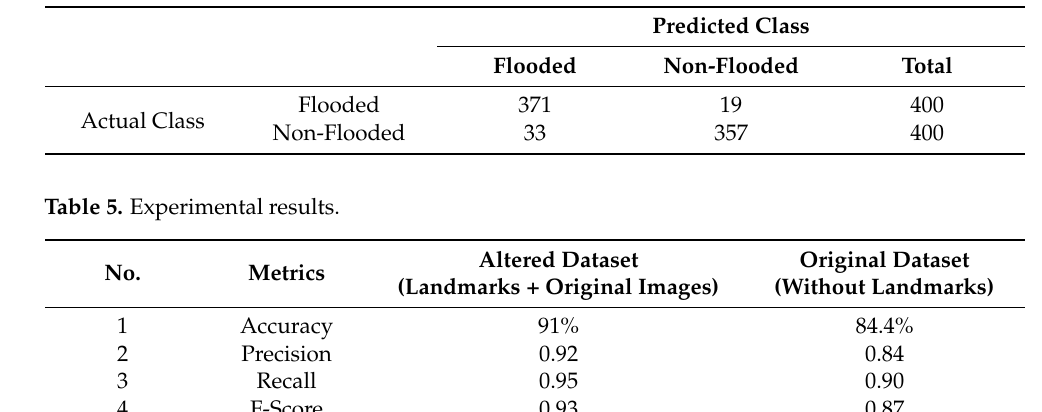
Table 4. Confusion matrix generated for a model trained using an altered dataset.